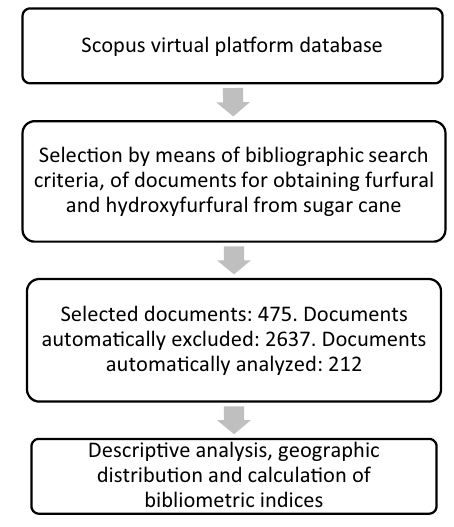
Fig. 1 Outline of the study results (Source: the